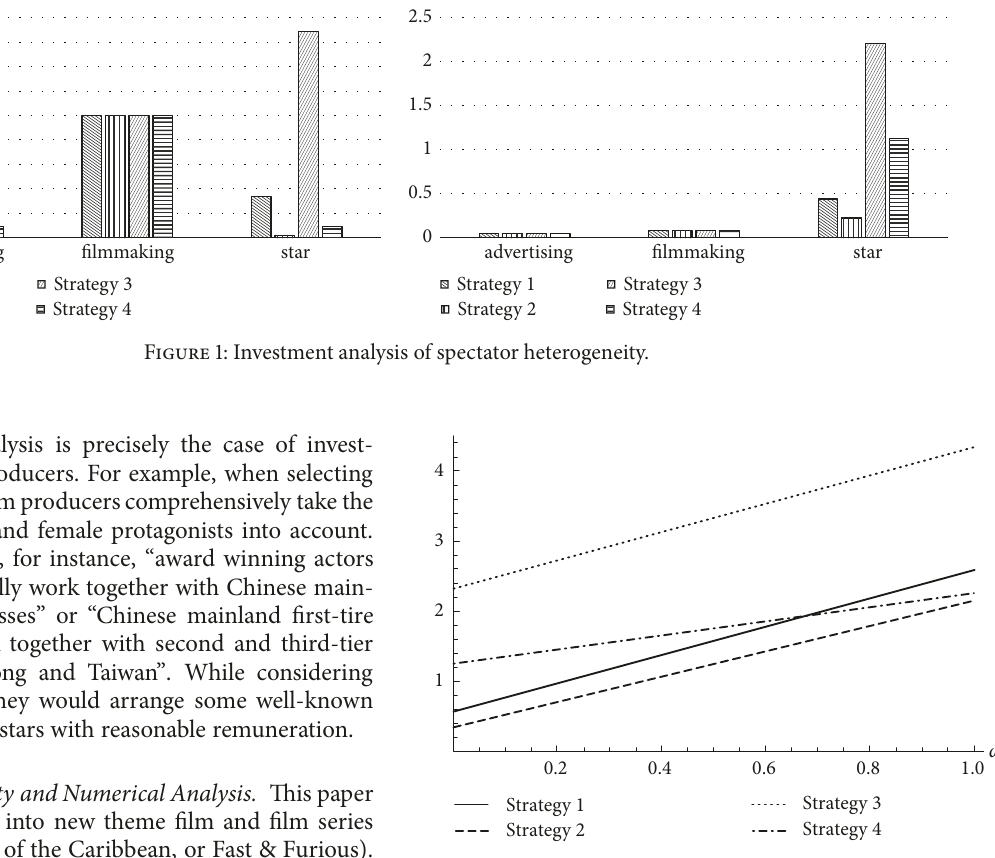
Figure 2: Total movie cost under different star selection strategies.